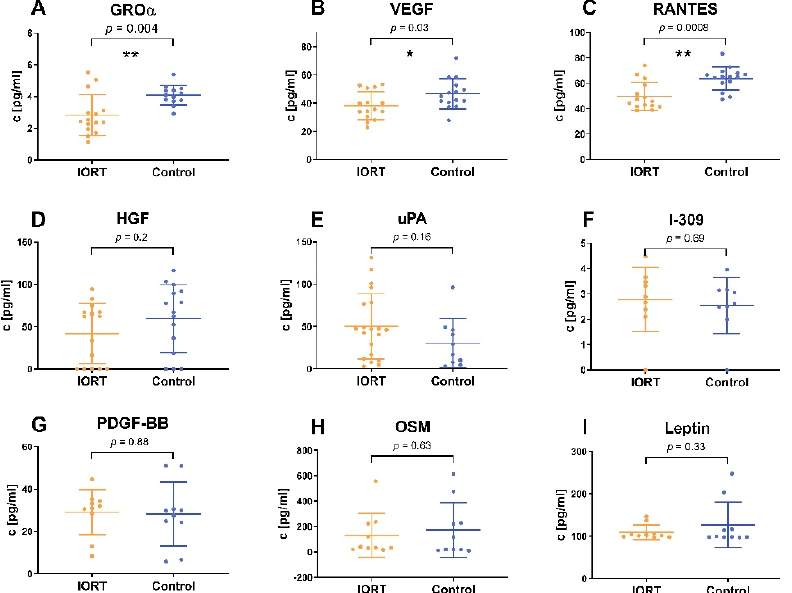
Figure 6. Cytokine concentrations in MSC conditioned media for GRO α ( A ), VEGF ( B ), RANTES ( C ), HGF ( D ), uPA ( E ), I-309 ( F ), PDGF-BB ( G ), OSM ( H ) and leptin ( I ). All experiments were reproduced in three independent experiments, with each 8–12 technical replicates in each condition (IORT = yellow, control = blue). Indicated values: mean ± standard deviation, statistical analysis by double sided t test, * p < 0.05, ** p < 0.01).